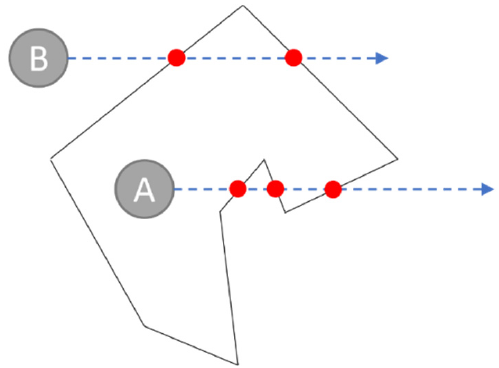
Figure 15. The ray ‐ casting algorithm. Figure 15. The ray-casting algorithm.